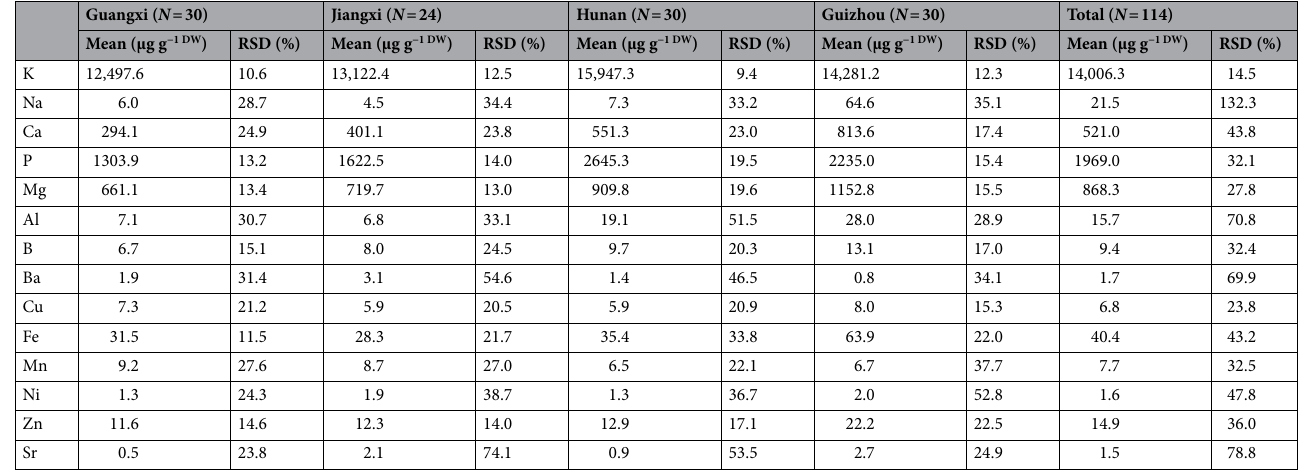
Table 1. Mean and RSD of the trace element contents according to their